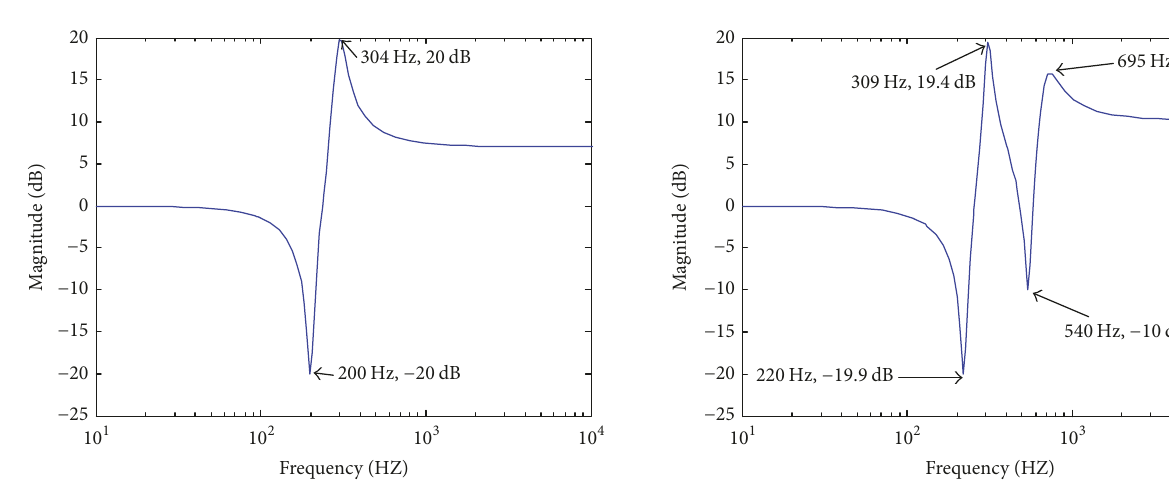
Figure 6: Bode diagram of one resonance mode. Figure 7: Bode diagrams of two resonance